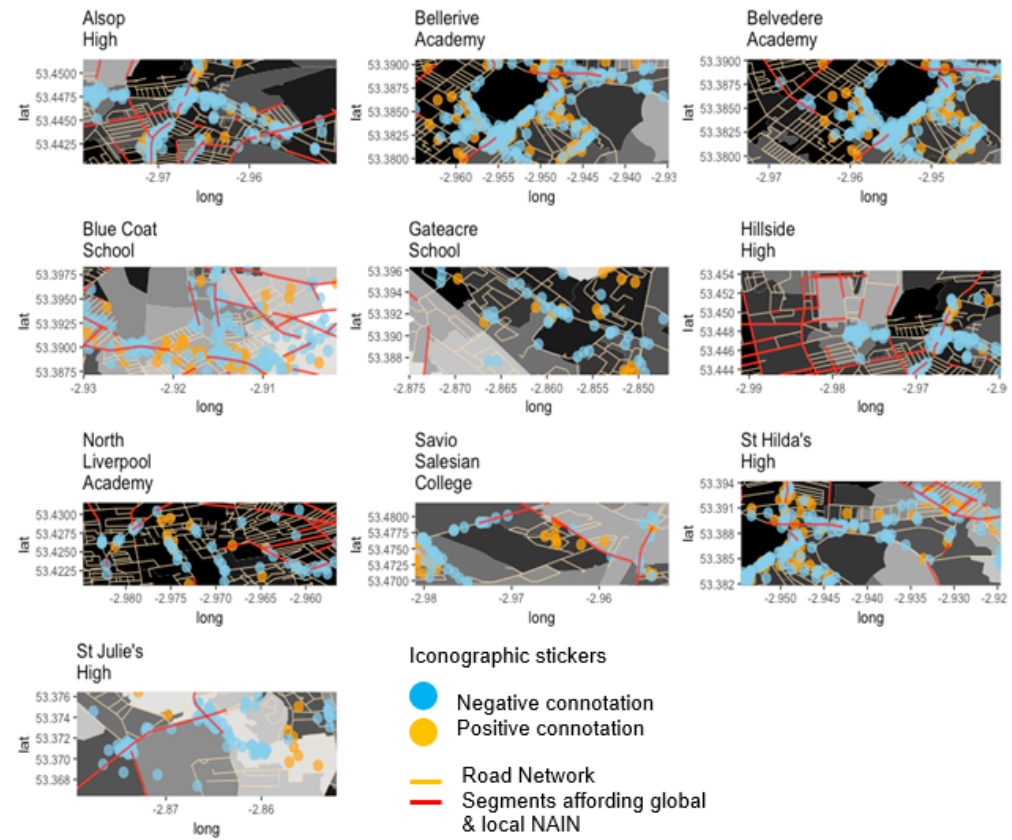
Figure 12. Array of community samples showing extract Depthmap segments overlaid on IMD by LSOA (Liverpool case study). Blue points represent negative weights such as ‘sad’, ‘shocked’, etc. Orange represents positive weights such as ‘love’, ‘happy’